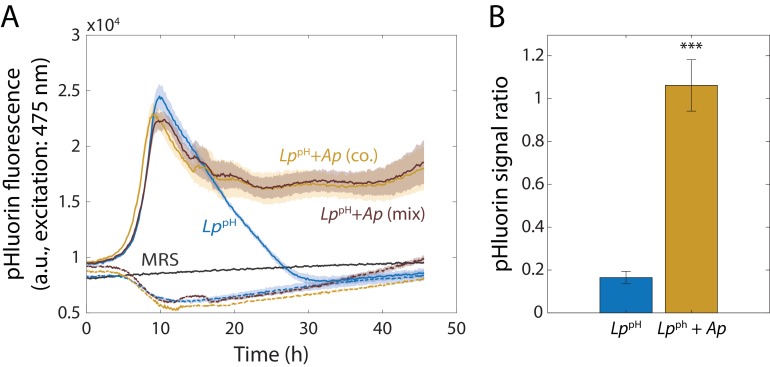
L. plantarum (Lp) intracellular pH is higher in stationary phase when grown with Acetobacter pasteurianus (Ap).(A) Intracellular pH of Lp decreases upon entry to stationary phase in monoculture but not in co-culture with Ap. A strain of Lp containing a plasmid expressing the pH-sensitive GFP pHluorin (LppH) was grown in monoculture, co-cultured with Ap, or mixed with Ap at the start of the experiment. Fluorescence emission (at 509 nm) was measured at an excitation wavelength of 475 nm over time, and is correlated with pH. Shaded regions indicate standard deviation (S.D.), n = 3. Cultures of the parent strain without pHluorin (Lp, dashed lines) and MRS alone (gray) were included as controls. Data points were taken every 8.3 min. (B) Intracellular pH increases in co-cultures of LppH and Ap after 48 h of growth. Fluorescence (emission at 509 nm) was measured for two excitation wavelengths (405 and 475 nm) after resuspending pHluorin-harboring cells in PBS. The ratiometric signal scales with pH. Error bars are S.D., n = 3. p-values are from a Student’s two-sided t-test of the difference from the monoculture (***: p<0.001).